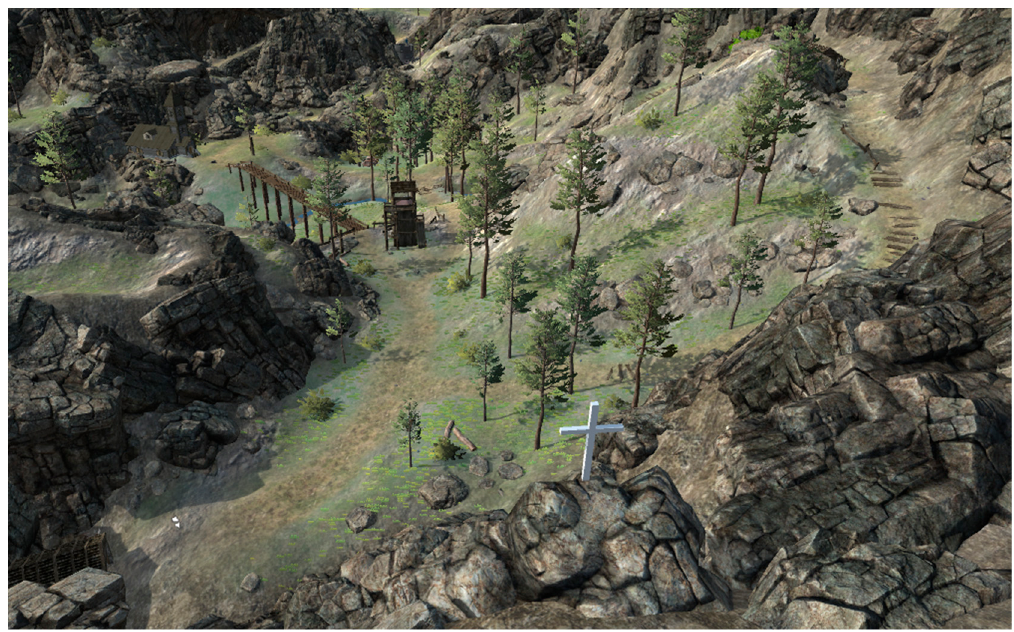
Figure 2. An elevated view of the experimental environment (map A) the participants were asked to explore.